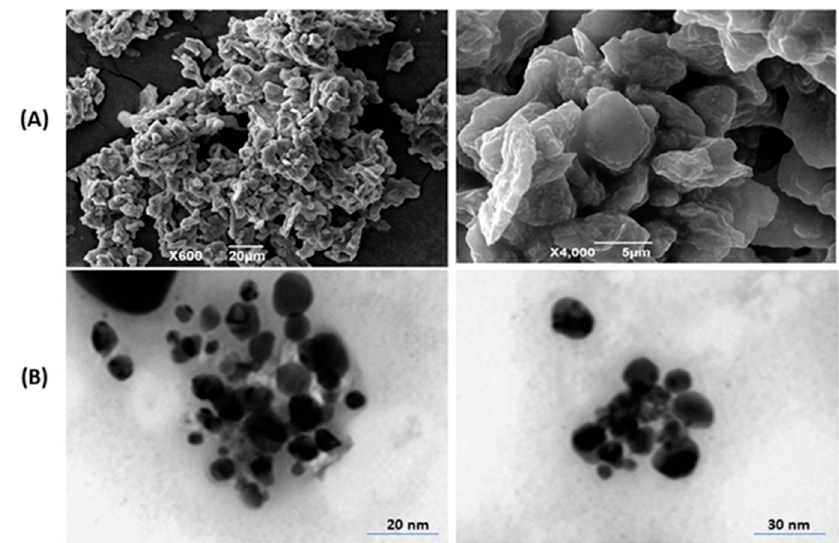
Figure 4. ( A ) Scanning electron microscopy (SEM) images of PrSNPs from different cross-sections at different magnification (×600, ×4000) and ( B ) transmission electron microscopy (TEM) images of optimized PrSNPs at different scale bars.